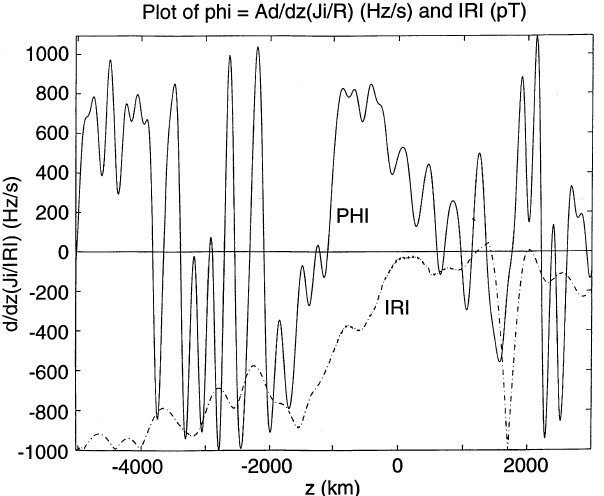
Fig. 9. Case A. Plot of { Vg 2 x o = k o (cid:1) d = d z (cid:133) J i = R (cid:134) } in Hz/s as a function of z at t = 2 s. A prominent peak (cid:24) (cid:135) 800 Hz/s will be noticed at the left hand end of the GR